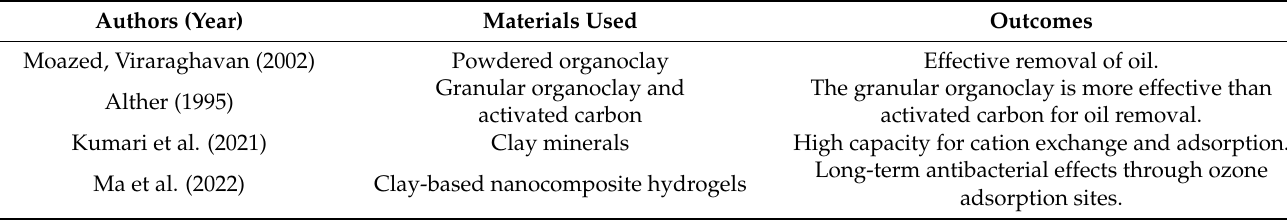
Table 9. Recent studies of clay minerals for removal of oil from wastewater.